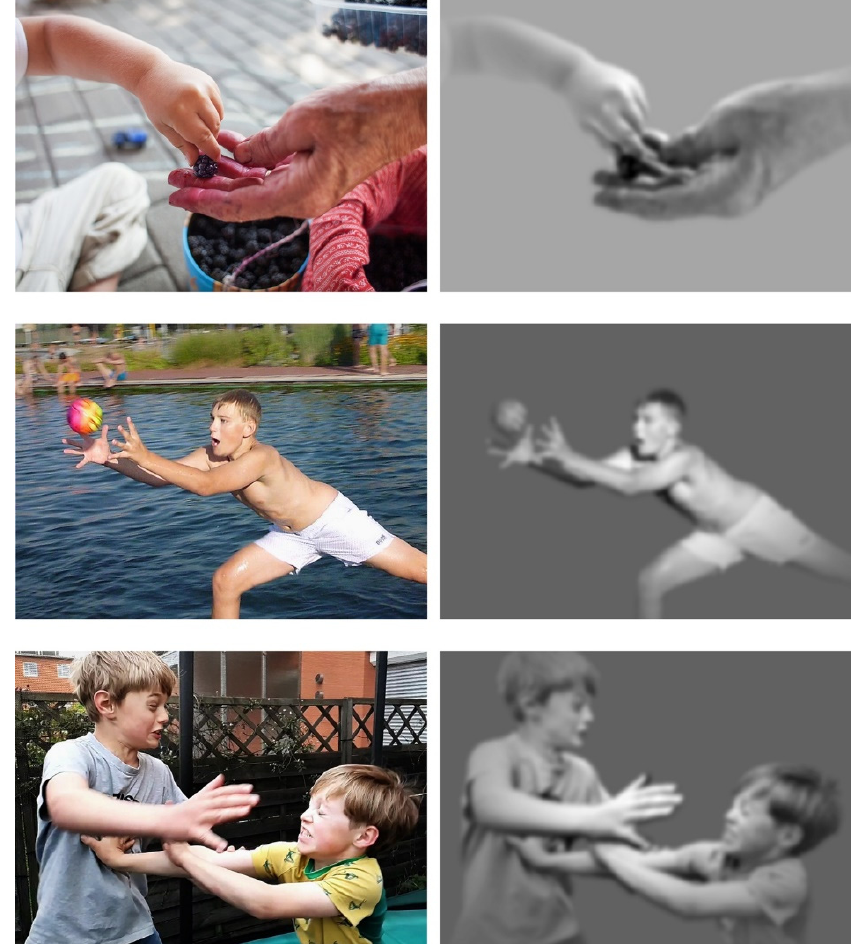
Figure 1. Visual information of action photos that is assumed to be relevant to rapid responses in the action observation network (AON). Note. The picture on the left is the original photo. The modified picture on the right is a hypothetical illustration, of which information from the original photo is relevant with regard to processing in the AON in the early time window up to around 300 milliseconds after picture onset. It has been assumed that the photos were presented to the viewers on their smartphone, which they were holding, and that they had their gaze directed to the display when the photos appeared. The photos had a size of 1505 × 1080 pixels. The viewing angle was 10 × 14°. The spatial resolution of the proposed modifications was based on recent findings on the magnocellular visual pathway [110–112,114,115]. The extraction of coarse-scale information during the processing of the picture information in the magnocellular pathway suggests that a distinction between foveal and peripheral vision is not necessary in the first hundreds of ms after picture onset. This assumption is also supported by the analysis of the processing of visual information about moving faces or bodies by Pitcher and Ungerleider [43]. Viewers, however, do not process the entire picture information uniformly but rather select the information in the center of the picture rather than information along its edges [140]. Picture information that is irrelevant to the processing in the AON has been removed in the modifications. They only represent bodies, body parts, faces, and objects that are involved in the actions. All changes to the original photos were made by using Adobe Photoshop (version 21.1.3, Adobe Systems, San Jose, CA, USA). The original color photos were converted into grayscale pictures. Based on studies on magnocellular performance, the modifications had a spatial resolution of 4 cycles per degree [114,115]. The spatial filtering was applied by using a Gaussian blur filter with a 9-pixel kernel for low-pass filtering. In illustrating the center bias of processing, I used a selection mask that corresponded to the “Weight Matrix” in Hayes and Henderson [140] (Figure 2, Panel h). Brightness and contrast were reduced according to the distance to the center of the image. The overall brightness of the modifications corresponded to the original photos. The photos were taken by the author.